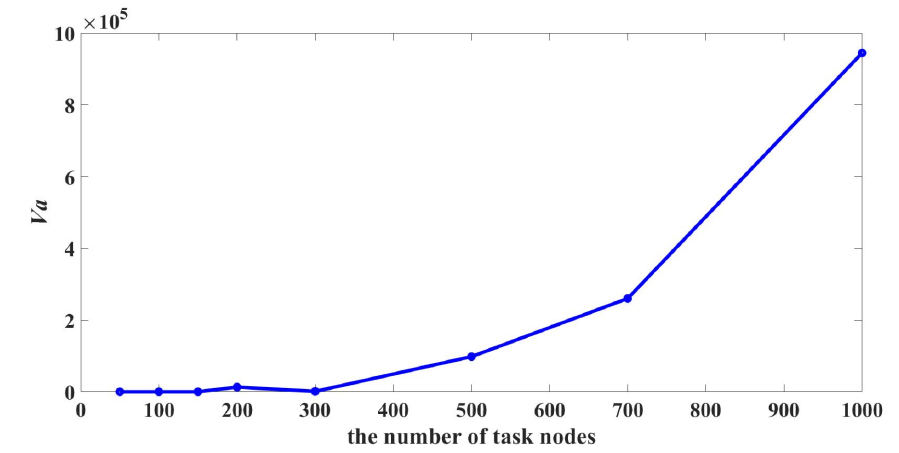
Figure 9. The values of Va of the eight